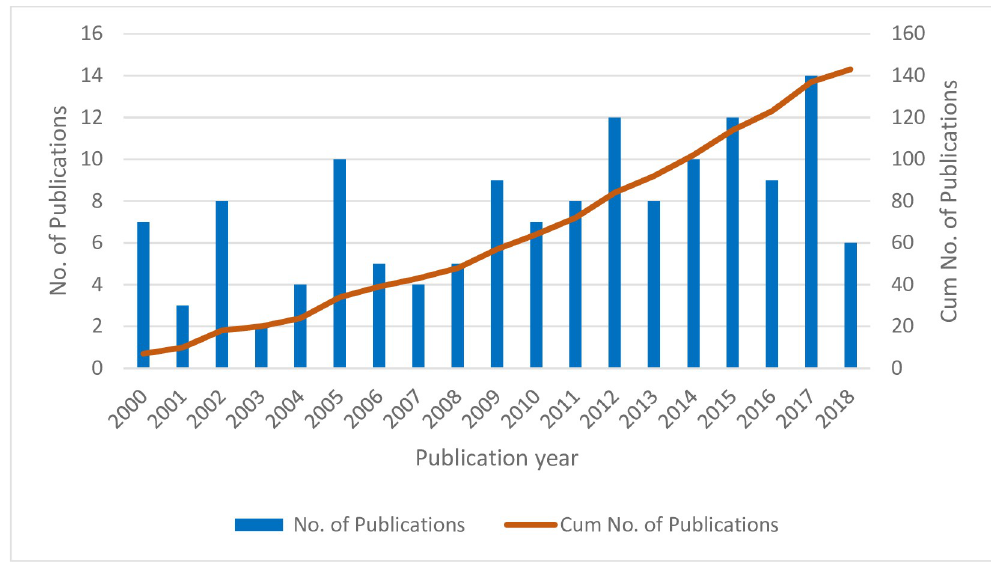
Fig 2. Temporal distribution of studies of EEG indices in cognitive